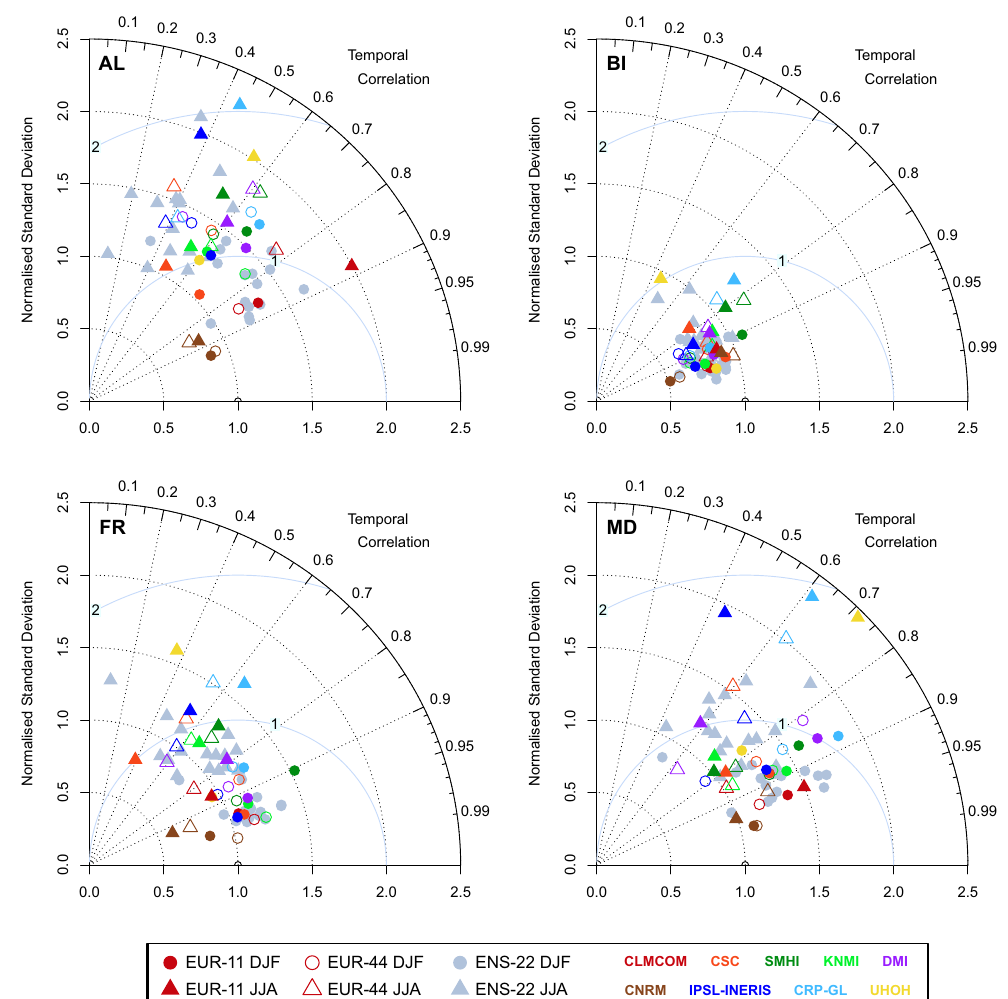
Figure B8. As Fig. B7 but for mean winter (circles) and mean summer (triangles) precipitation. See Fig. 12 for subdomains EA, IP, ME and